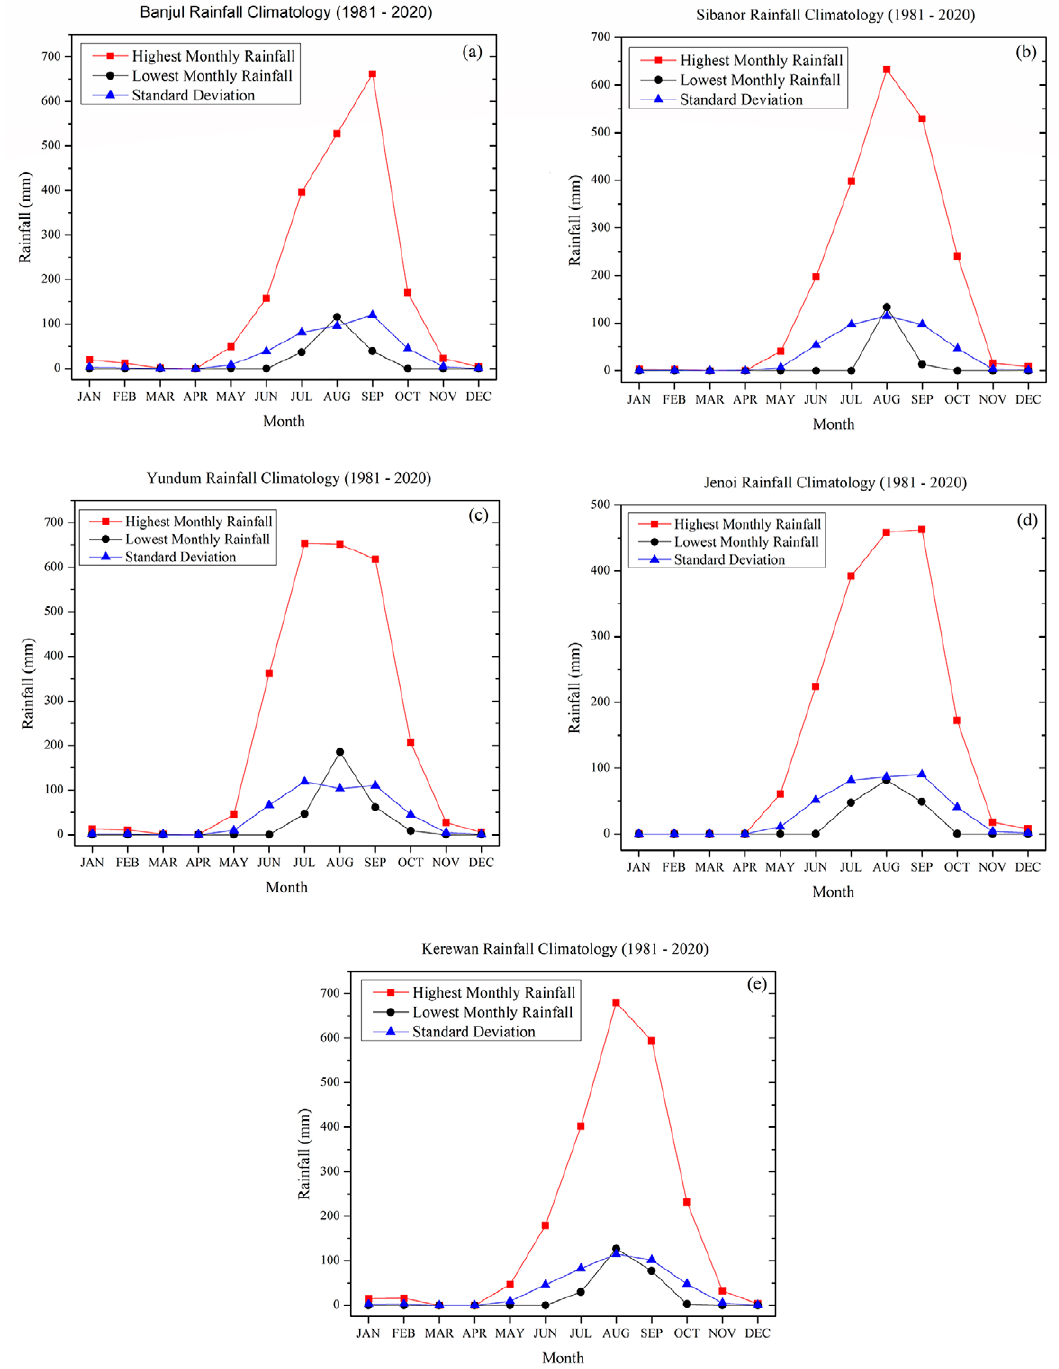
Figure 5. Rainfall variability at individual stations (Western